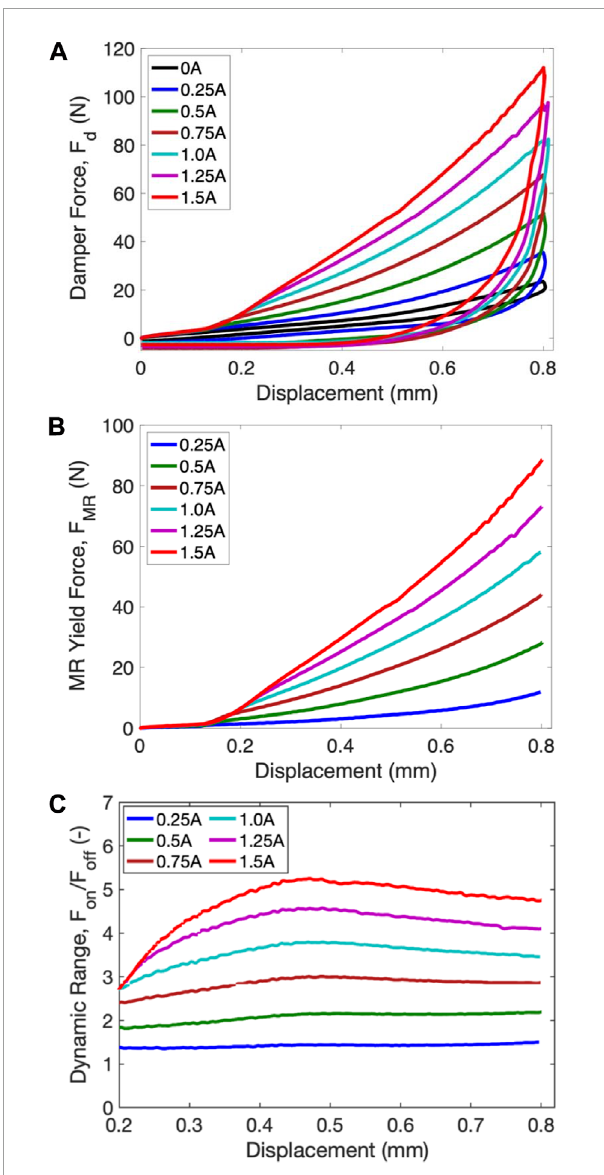
FIGURE 6 Magnetic field-controllable performances of the 3D-printed MRVI after 156 days. (A) F d . (B) F MR in compression direction. (C) DR in compression